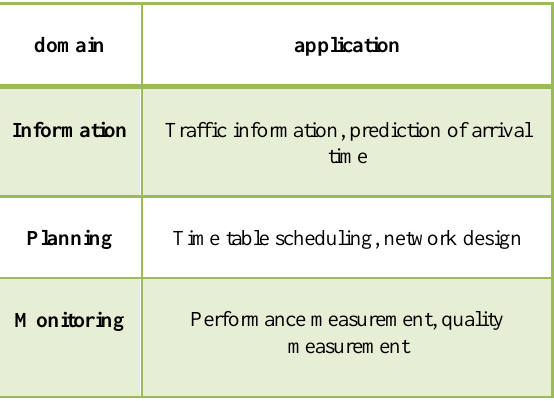
Table 1. Three main domain of VGI in public transport